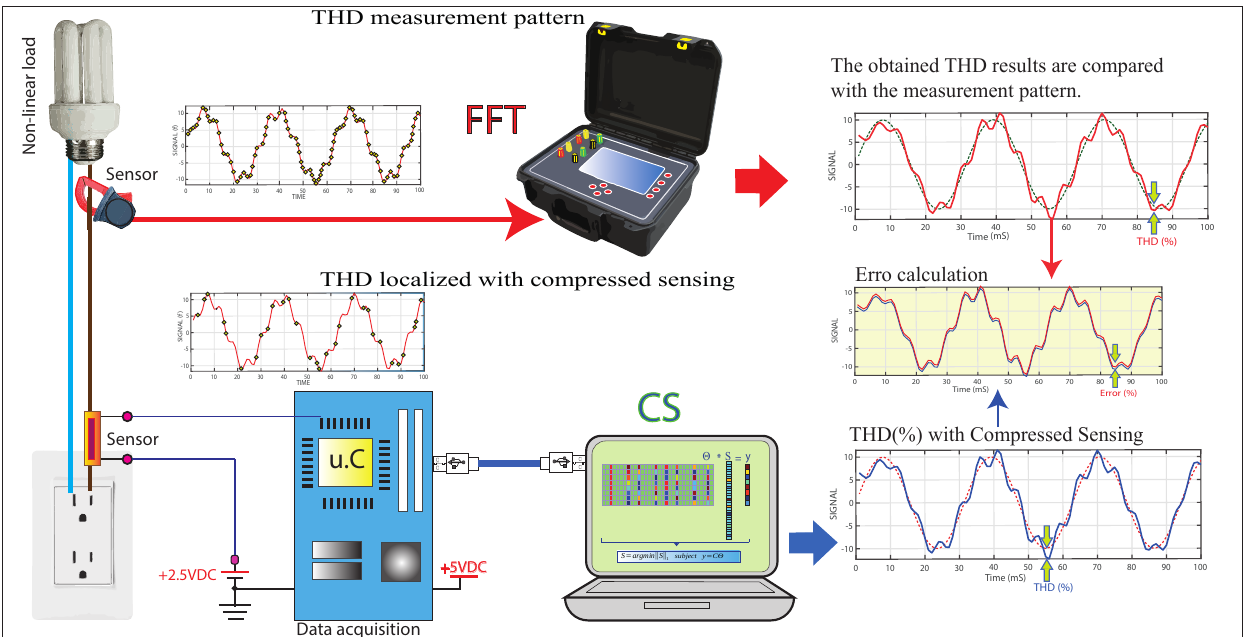
Figure 1. Process diagram of harmonic distortion detection by compressed